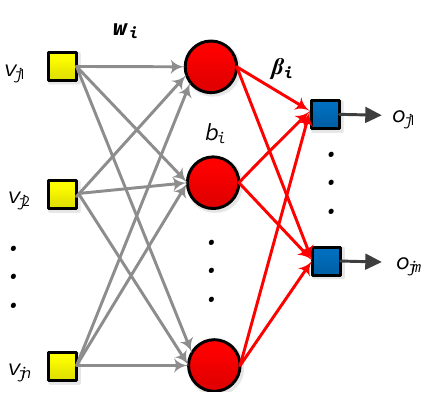
Figure 4. Structure of an ELM.